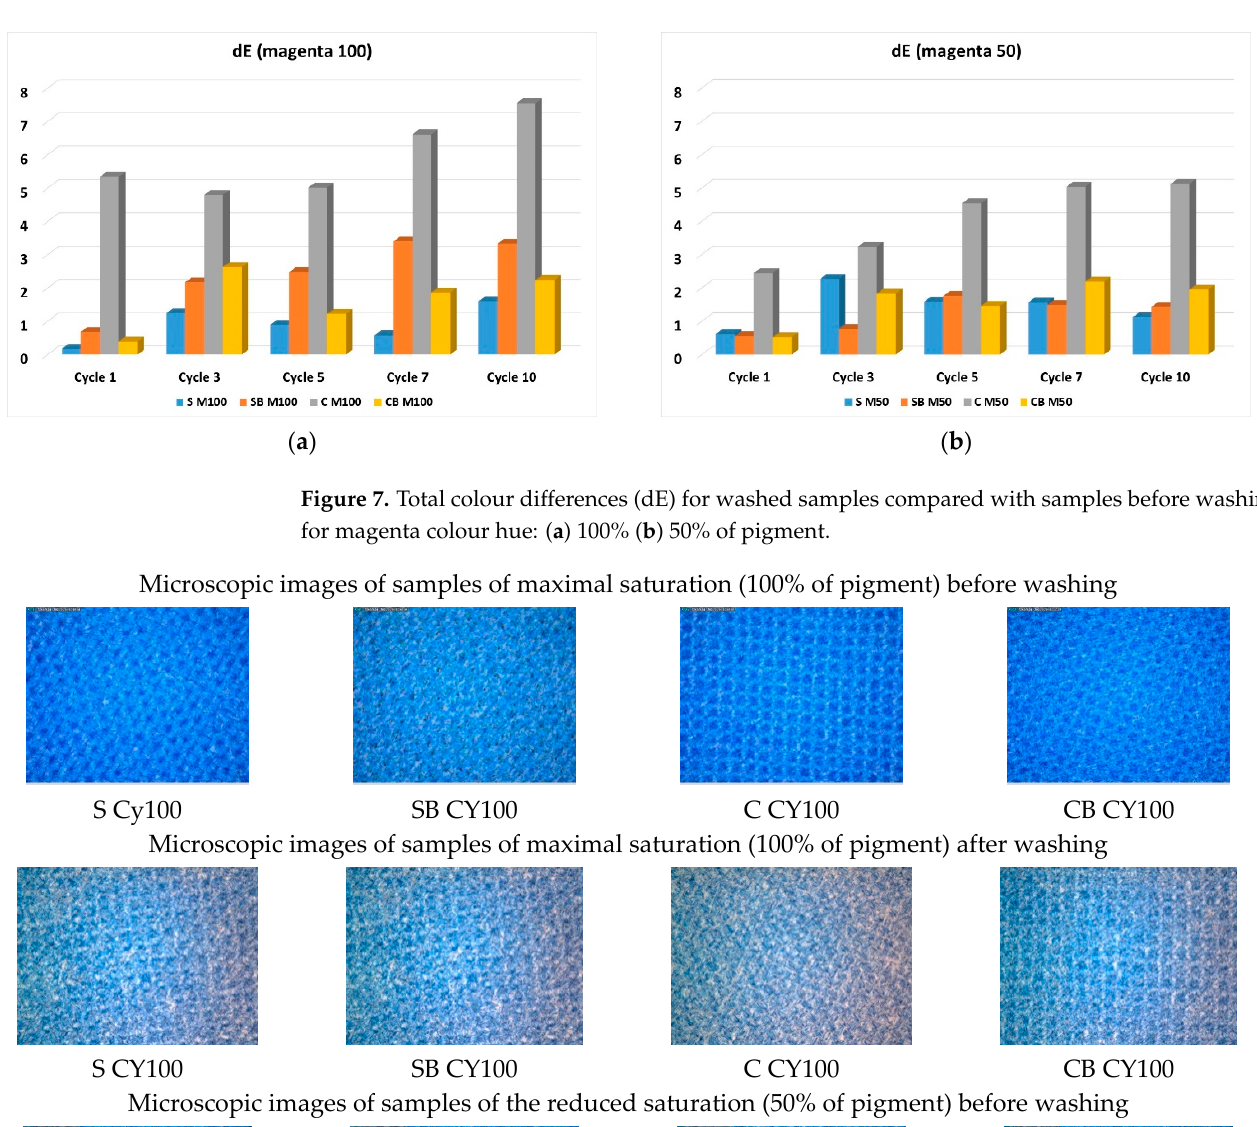
CB M50 Figure 6. Microscopic images of samples printed in magenta colour hue, before and after the 10th washing cycle. Also, visual analysis of the washing effect reveals, in general, lower damage of the pigment layer in cationized fabrics. Namely, in the case of binder-free samples, there is a deeper penetration of pigment within the fabric structure. The influence of the surface structure of textiles is more pronounced, resulting in darker and less saturated colours. By applying the binder, a cross-linked three-dimensional polymer structure is created on the surface of the fabric, which keeps the pigment on the surface, and the entire layer is thicker, more even and the influence of the structure is less pronounced. However, due to the retention of the pigment layer on the textile surface, in samples with the addition of